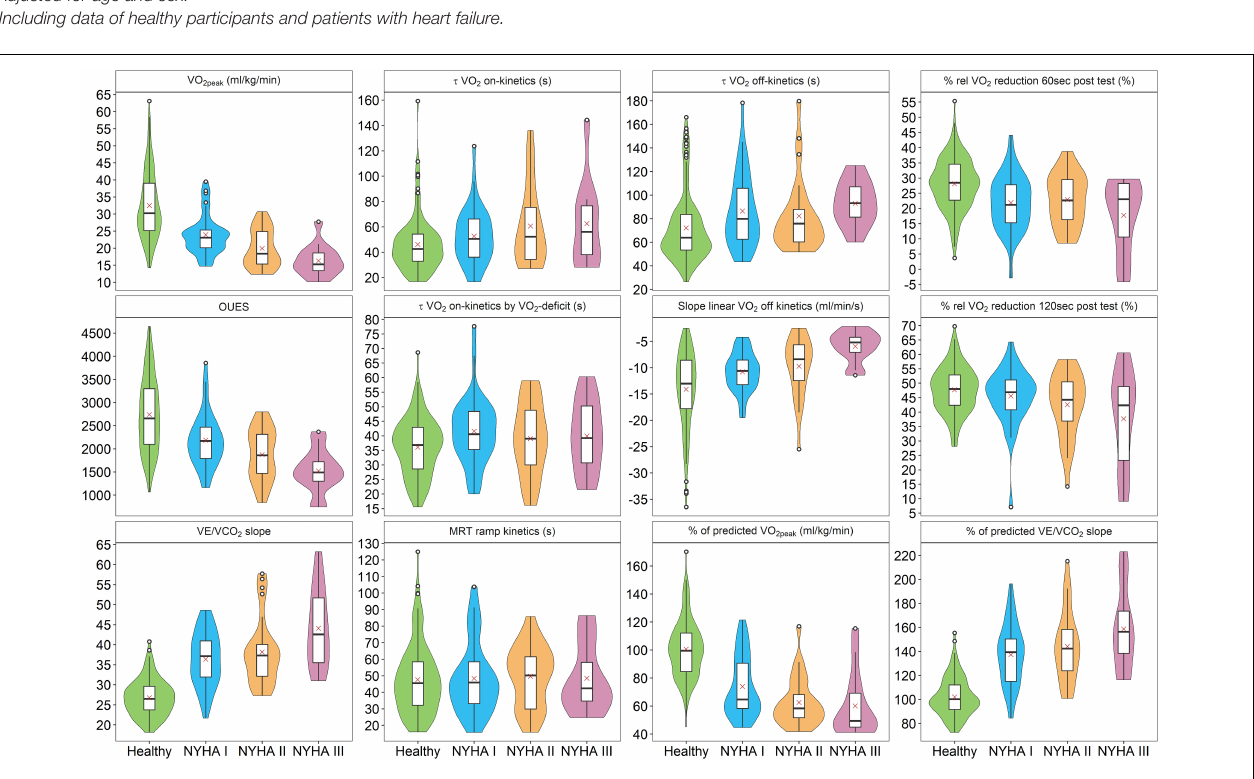
FIGURE 2 | Comparison of VO 2 on-kinetic und VO 2 off-kinetic parameters between a healthy control group and patients with heart failure with NYHA functional classes I, II, and III. ˙VO 2peak , peak oxygen uptake; OUES, oxygen uptake efficiency slope; VE, volume of expiration; VCO 2 , carbon dioxide output; τ , tau; MRT, mean response time; rel,